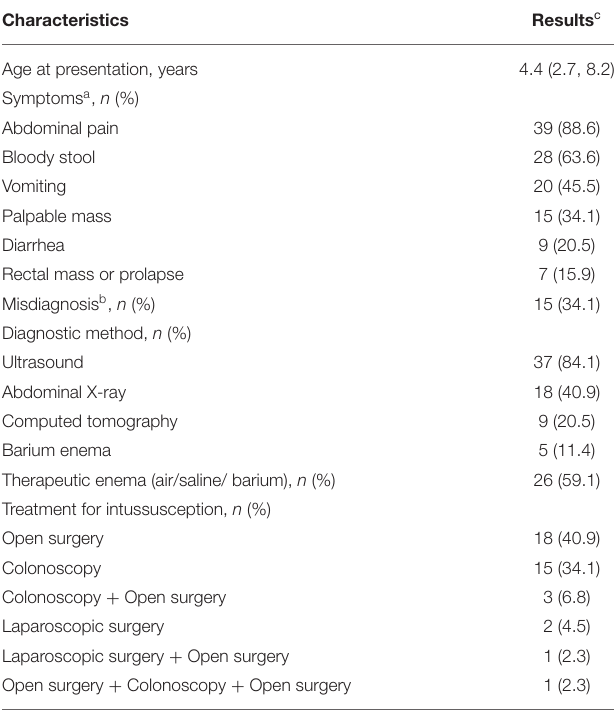
TABLE 4 | Diagnosis and treatment of patients with colocolic intussusception ( N = 44).